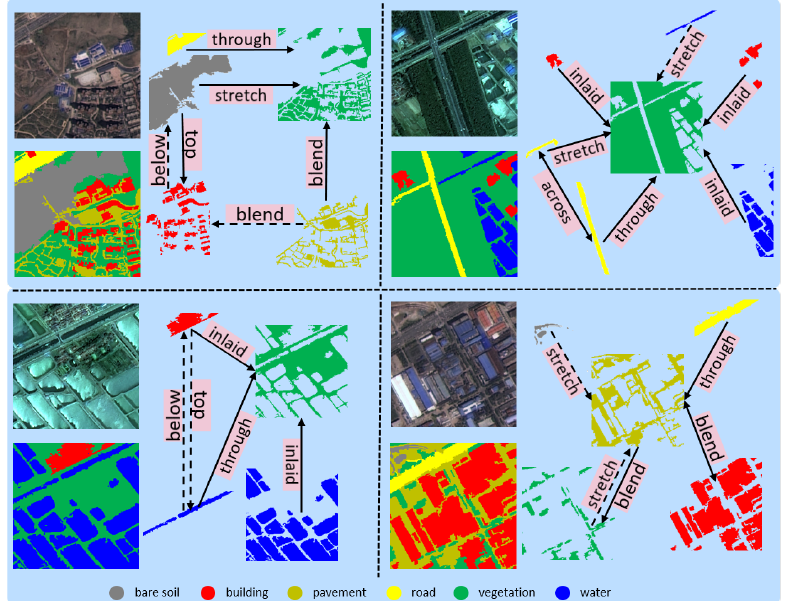
Figure 6. The illustration for scene graphs of remote sensing images is generated based on segmen- tation results. Each sub-image is followed by the visible light image of the remote sensing image, the corresponding segmentation result, and the generated scene graph. The nodes of the scene graph are represented by the segmentation results of the corresponding instances, and the semantic relationships between instances are represented by the predicates on the edges. The dashed lines indicate that the model failed to predict the relational predicate